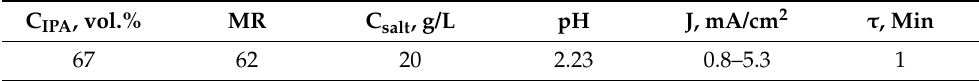
Table 5. The parameters of the reaction medium for determining the current density effect. C IPA , vol.%